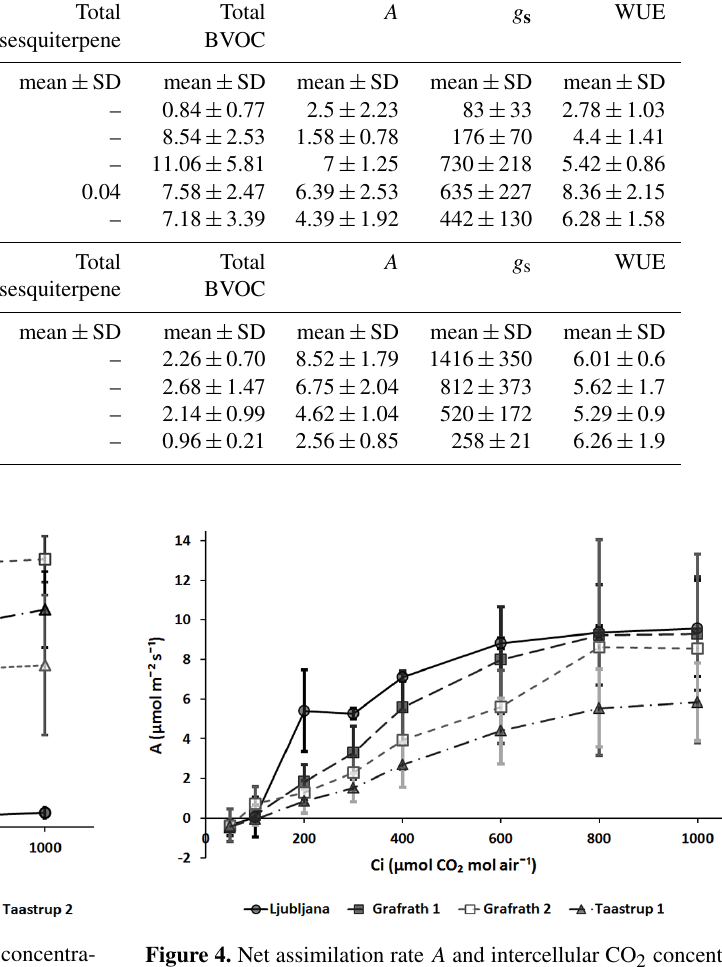
Figure 4. Net assimilation rate A and intercellular CO 2 concentra- tion ( C i ) response curves for European beech. The figure represents the average A - C i response curves for each tree ±